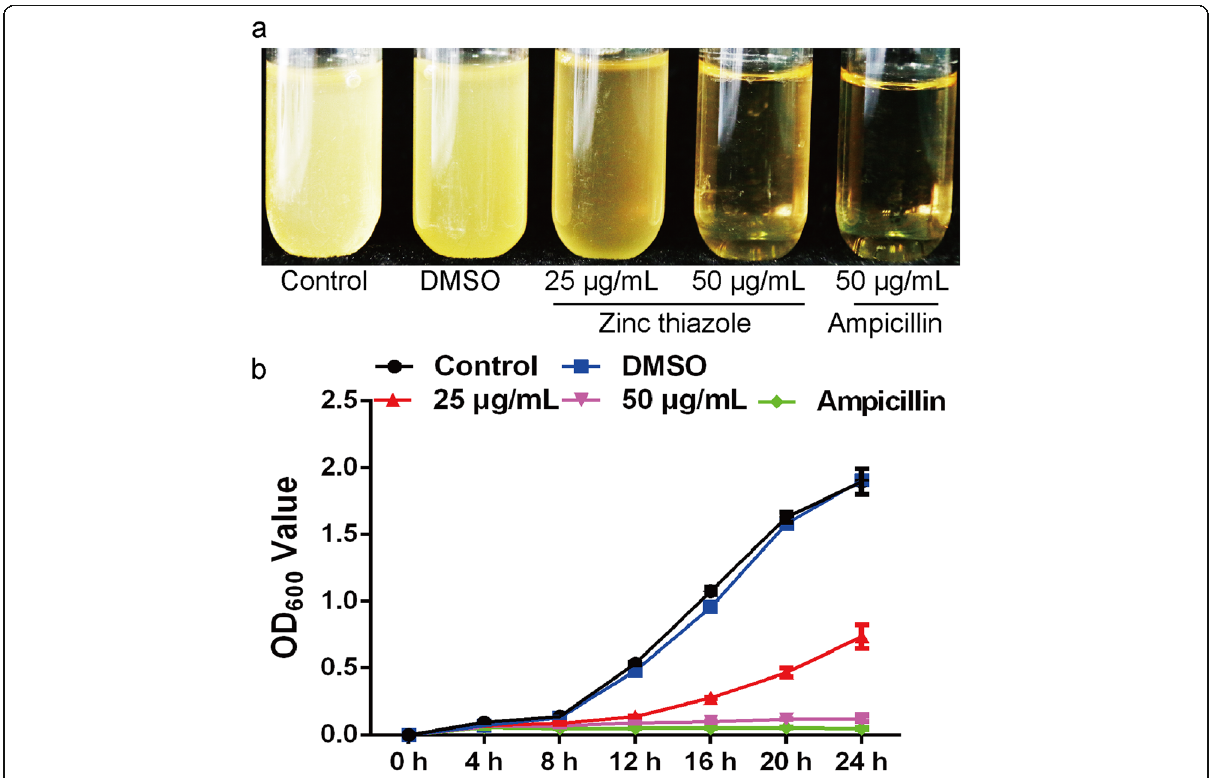
Fig. 3 Zinc thiazole inhibits the growth of Xoo . a Growth of PXO99 under zinc thiazole treatment. b Statistical analysis of growth curves of PXO99 treated with different concentrations of zinc thiazole and cultured for 24 h. Control indicates cell suspension of PXO99 (0 μ g/mL zinc thiazole without DMSO). DMSO (0.125%) was used as a negative control, and ampicillin (50 μ g/mL) was used as a positive control. Error bars represent standard errors from three independent